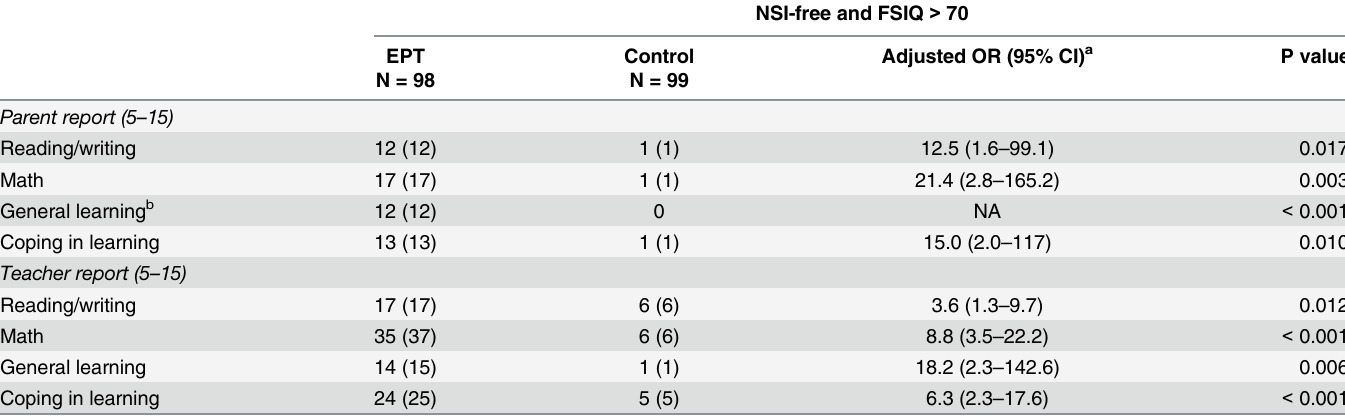
Table 6. Proportion of children in each group with FSIQ > 70 and without major NSI scoring in the clinical range for learning skill problems ( > 2 SD) on the parent and teacher FTF.